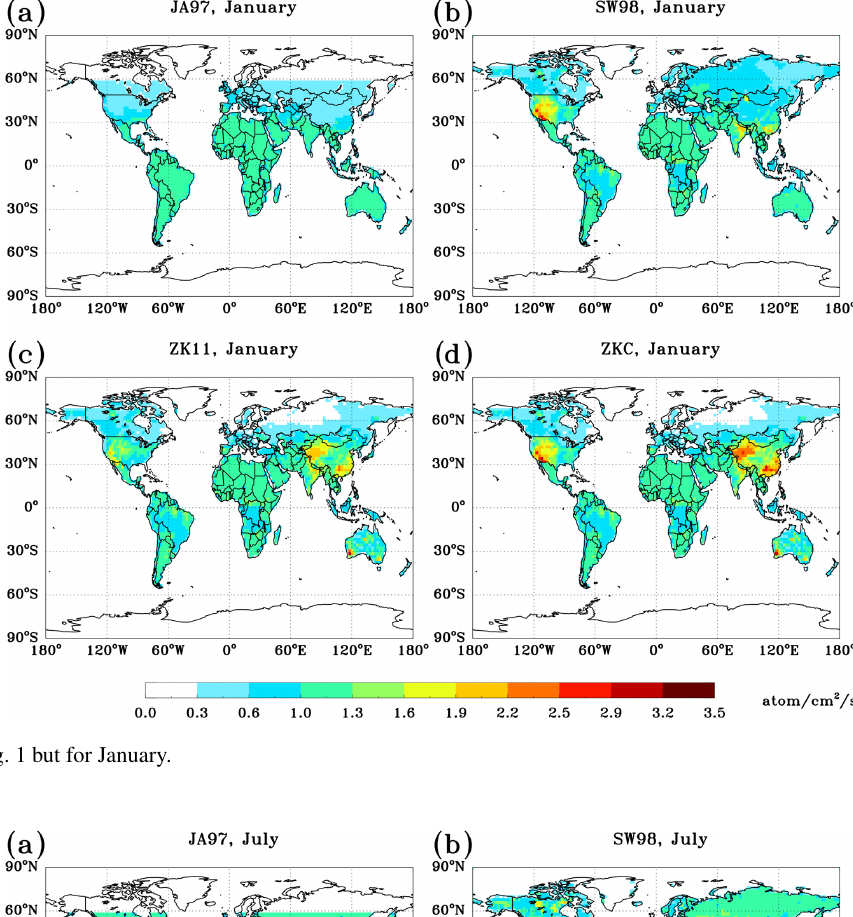
Figure 2. Same as Fig. 1 but for January.